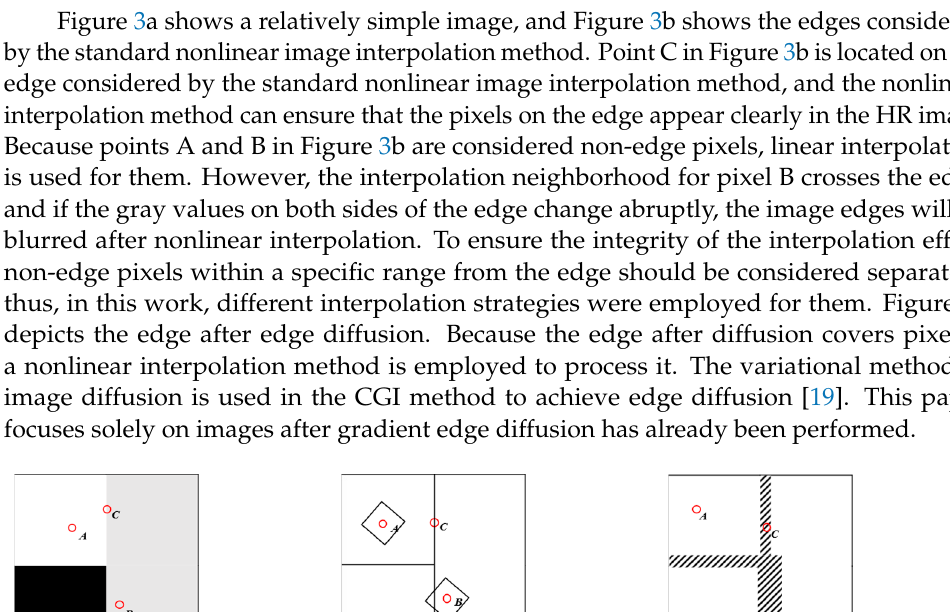
( c ) edge using the CGI method.